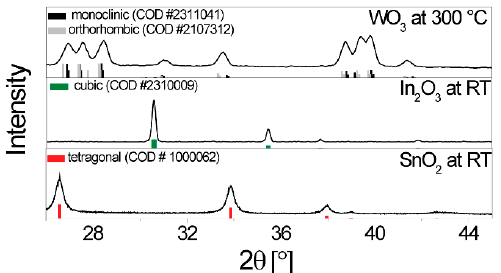
Figure 1 . X-ray diffractograms taken of the sensitive layer on the sensors (SnO 2 and In 2 O 3 at room temperature; WO 3 was recorded on a heated sensor). The reference patterns are from the Crystallography Open Database.